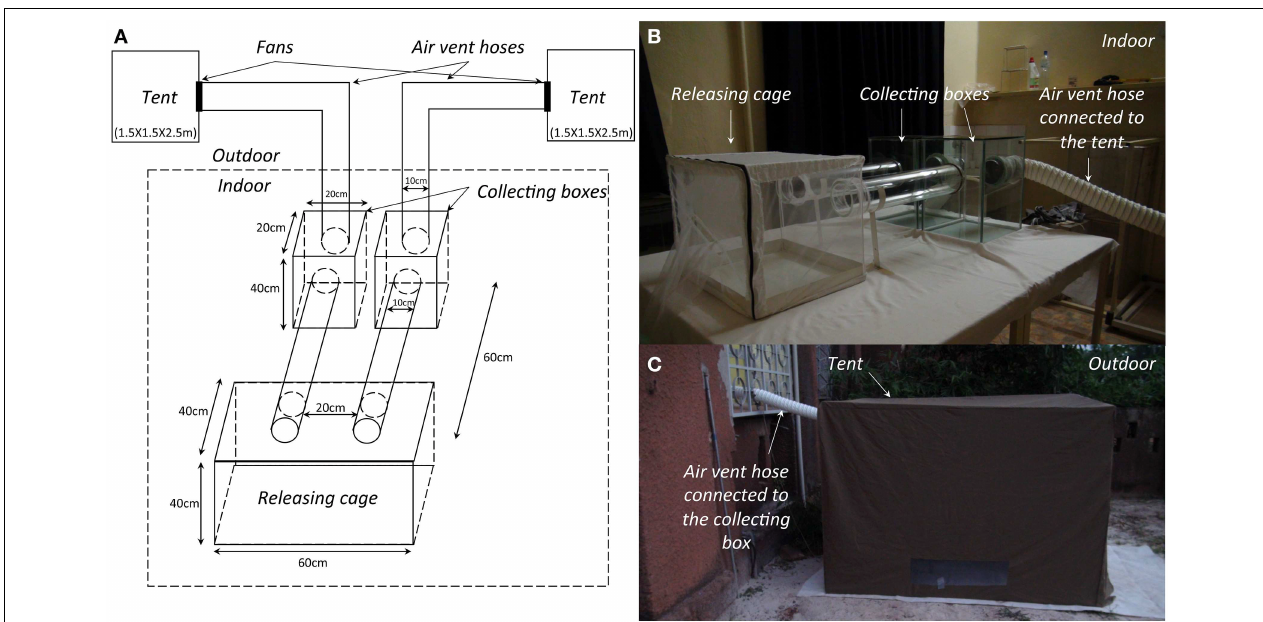
FIGURE 1 | (A) Schematic representation of the dual-port olfactometer. (B) Photo of the indoor part of the device. (C) Photo of the outdoor part of the